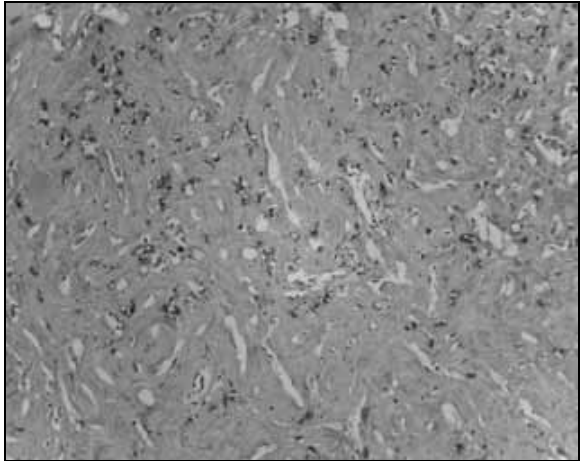
Figure 4 – Epithelioid cells showed positive immunoexpression for EMA, streptavidin- -biotin (100×) EMA: epithelial membrane antigen.